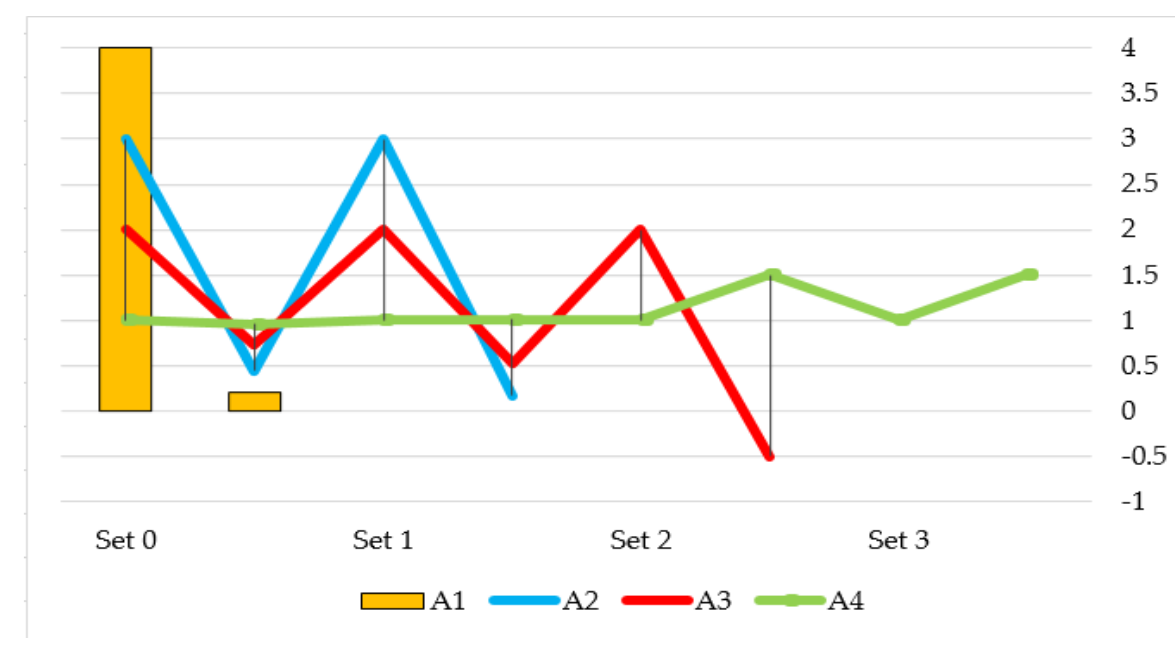
Figure 8. Results of the analysis of changes in the decision matrix size.